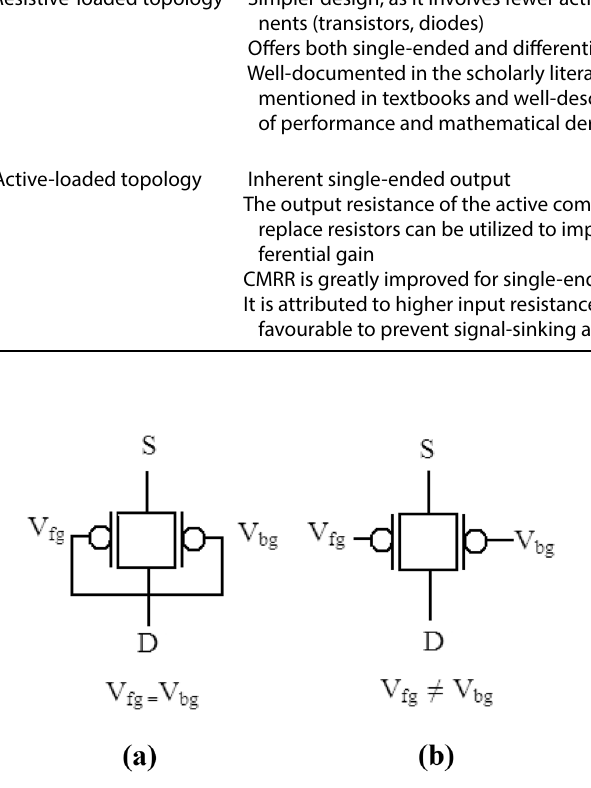
Fig. 4 DG MOSFET as a Symmetrically driven, and b independently driven, where V is the front-gate voltage and V fg voltage